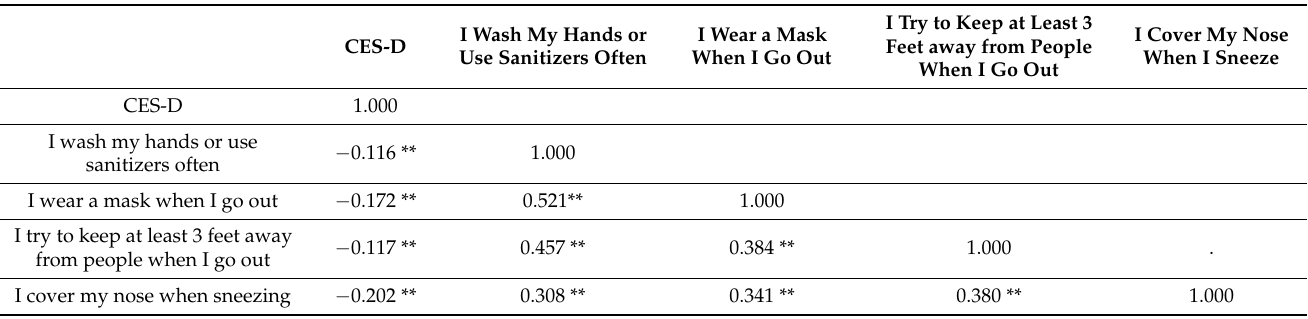
Table 3. Correlations between depressive symptoms and adherence to precautionary measures among male undergraduates ( n = 1161).